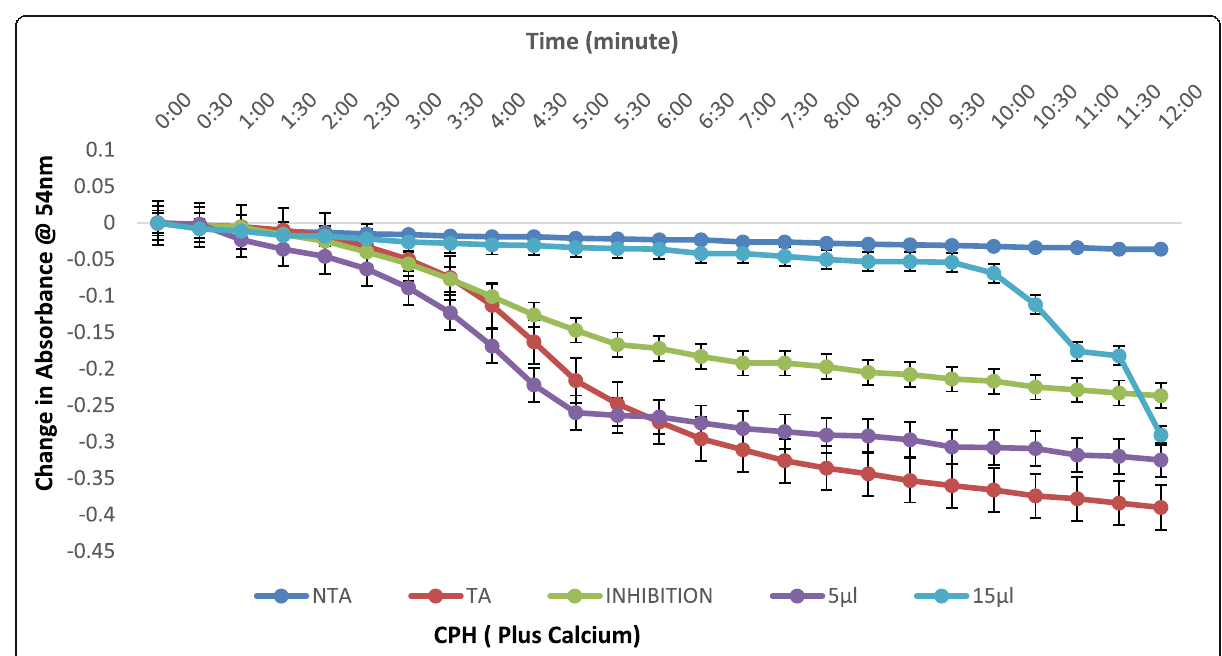
Fig. 6 Effect of varying concentrations (10 μ g/ml, and 30 μ g/ml, corresponding to 5 μ l and 15 μ l) of crude hot water infusion extract of Cassava biogas slurry on rat liver mitochondrial membrane permeability transition pore in the presence of calcium (Ca 2+ )